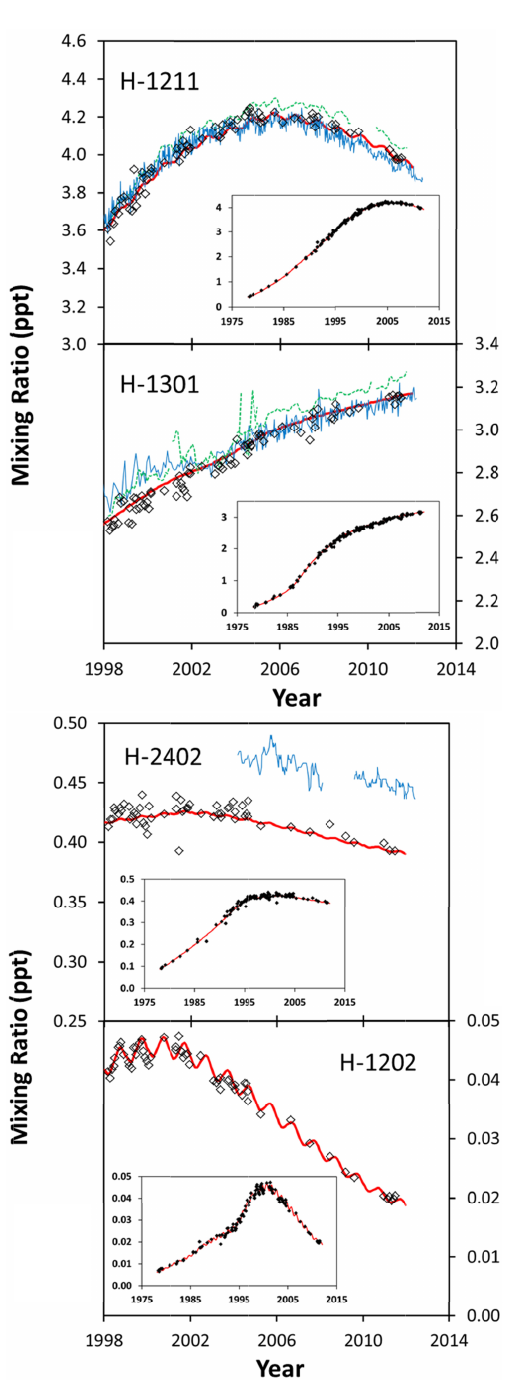
Fig. 1. Measured mixing ratios (ppt) of the halons from Cape Grim Figure 1. Figure 1. Measured Measured mixing ratios (ppt) of the halons from Cape Grim at UEA from 19 mixing ratios (ppt) of the halons from Cape Grim at UEA from 19 mixing ratios (ppt) of the halons from Cape Grim at UEA from 19 mixing ratios (ppt) of the halons from Cape Grim at UEA from 19 mixing ratios (ppt) of the halons from Cape Grim at UEA from 19 at UEA from 1998 to 2011 (open black diamonds). Solid red lines 2011 (open black diamonds). (open black diamonds). (open black diamonds). (open black diamonds). Solid red lines are the model Solid red lines are the model Solid red lines are the model runs used to derive emissions runs used to derive emissions are the model runs used to derive emissions. Solid blue lines for H- Solid blue lines for H Solid blue lines for H Solid blue lines for H-1211, H 1301 and H-2402 are measured mixing ratios (ppt) from Cape 2402 are measured mixing ratios (ppt) from Cape 2402 are measured mixing ratios (ppt) from Cape 1211, H-1301 and H-2402 are measured mixing ratios (ppt) from Grim by Grim by NOAA (Montzka and Elkins, 2012) Montzka and Elkins, 2012) Montzka and Elkins, 2012) Montzka and Elkins, 2012). Dashed green lines for H . Dashed green lines for H . Dashed green lines for H-1211 and H Cape Grim by NOAA (Montzka and Elkins, 2012). Dashed green measured mixing ratios (ppt) from Cape Grim by AGAGE measured mixing ratios (ppt) from Cape Grim by AGAGE measured mixing ratios (ppt) from Cape Grim by AGAGE measured mixing ratios (ppt) from Cape Grim by AGAGE measured mixing ratios (ppt) from Cape Grim by AGAGE measured mixing ratios (ppt) from Cape Grim by AGAGE measured mixing ratios (ppt) from Cape Grim by AGAGE (http://agage.eas.gatech.edu/ lines for H-1211 and H-1301 are measured mixing ratios (ppt) from Inset panels show the complete UEA record from C Inset panels show the complete UEA record from C Inset panels show the complete UEA record from C Inset panels show the complete UEA record from C Inset panels show the complete UEA record from C Inset panels show the complete UEA record from Cape Grim from 1978 to 2011 (solid black ape Grim from 1978 to 2011 (solid black Cape Grim by AGAGE (http://agage.eas.gatech.edu). Inset panels diamonds). diamonds). show the complete UEA record from Cape Grim from 1978 to 2011 (solid black